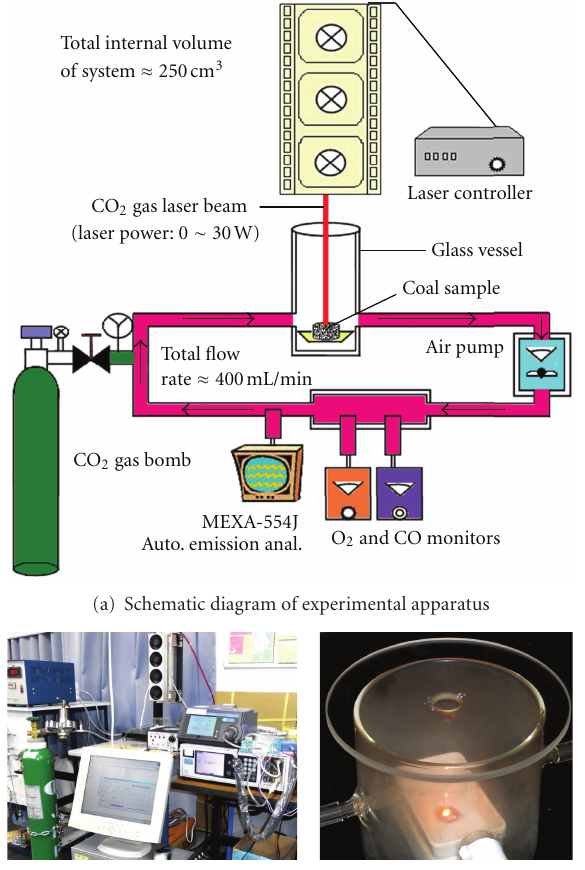
Figure 5: Experimental apparatus.